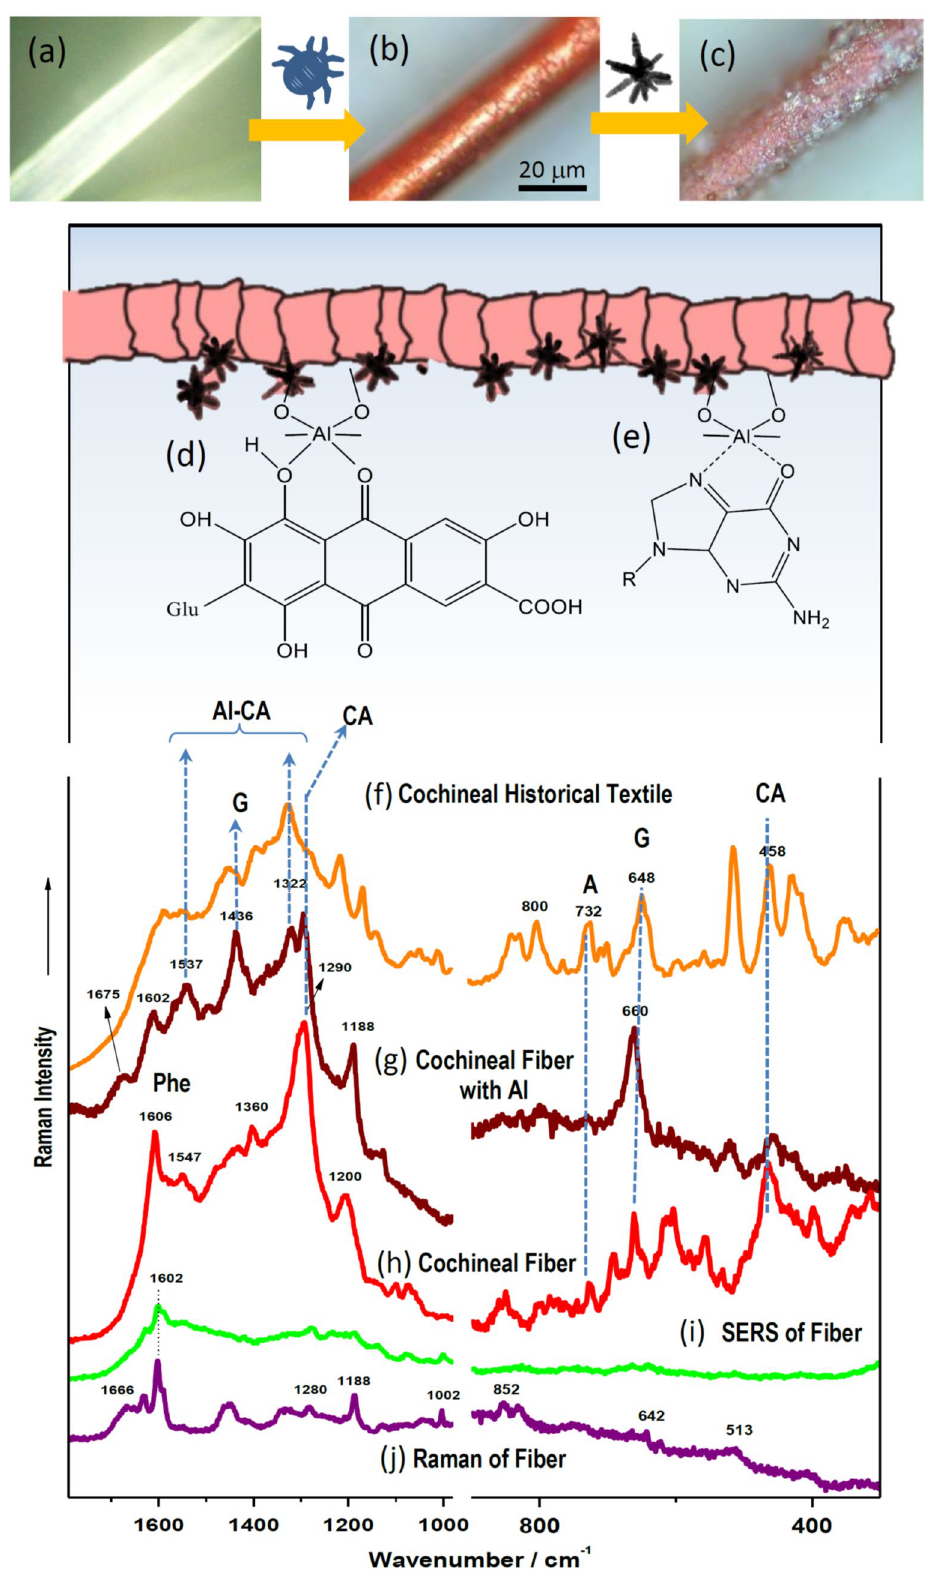
Figure 5. Steps followed to dye the commercial wool fiber ( a ) by the cochineal supernatant extract ( b ) and the Ag nanostars deposition to measure the SERS spectra ( c ). Schemes showing the Al-CA ( d ) and Al-G ( e ) interaction mechanisms deduced from the SERS spectra in mordanted cochineal dyes wool fibers. SERS spectrum obtained from the historical textile, in this case the orange fibers in the belt-bag of Fig. 2a ( f ); SERS spectrum of the cochineal dyed wool mordanted with Al 2 (SO 4 ) 3 ( g ); SERS spectrum of the cochineal dyed fiber without Al 2 (SO 4 ) 3 ( h ); SERS spectrum of non-dyed wool fiber ( i ) and Raman spectrum of the wool fiber ( j